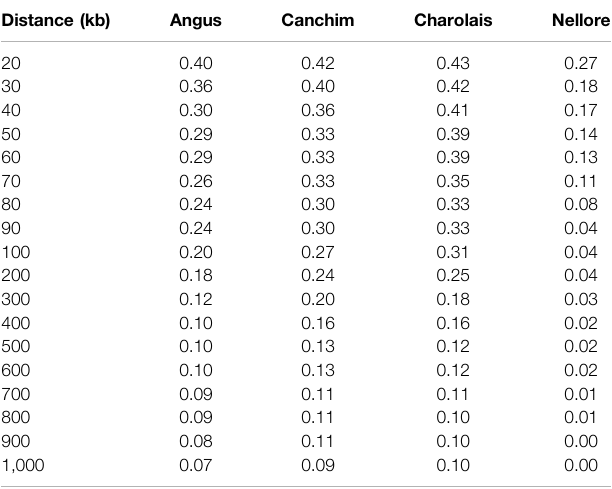
TABLE 2 | Consistency of the gametic phase based on Pearson correlation, between the Purunã breed and its founder breeds: Angus, Canchim, Charolais, and Nellore